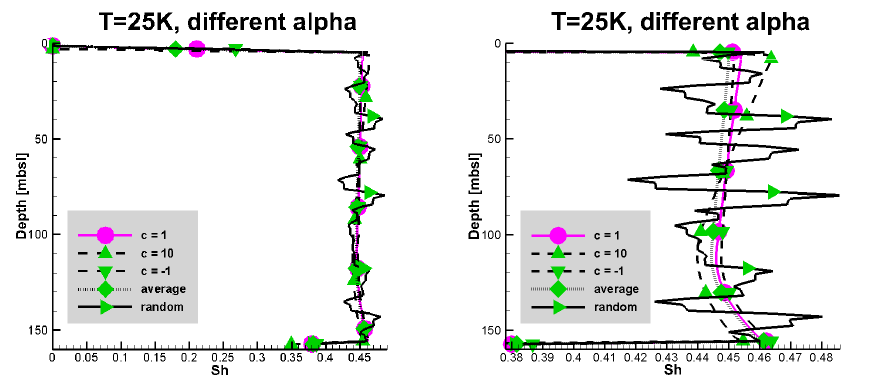
Figure 7. Hydrate saturation for different coefficients α . The figure on the ( right ) is a zoomed in version of that on the ( left